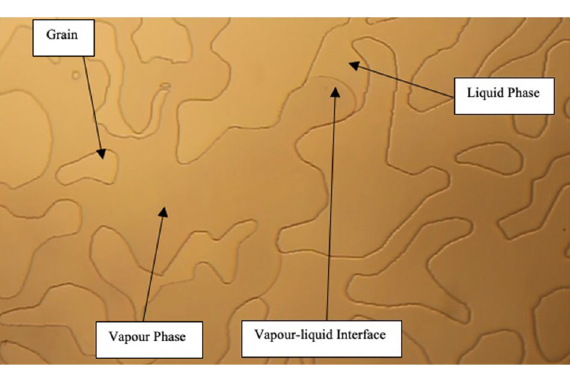
Vapour pressure (psi) Condensation pressure (psi)